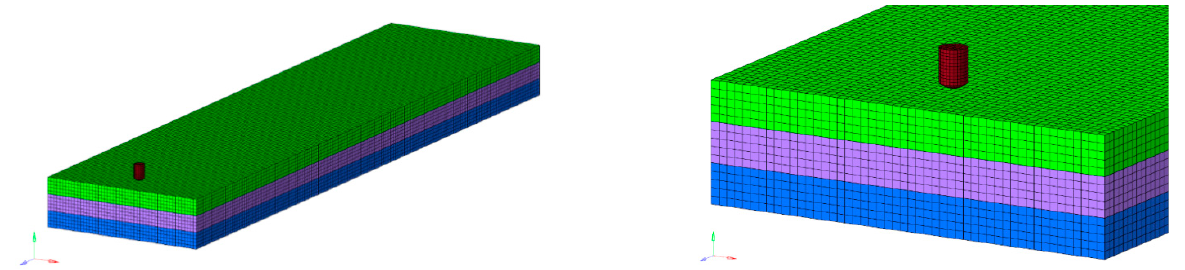
Figure 1. Calculation model of concrete slab impacted by drop hammer. Table 1. The parameters of materials.